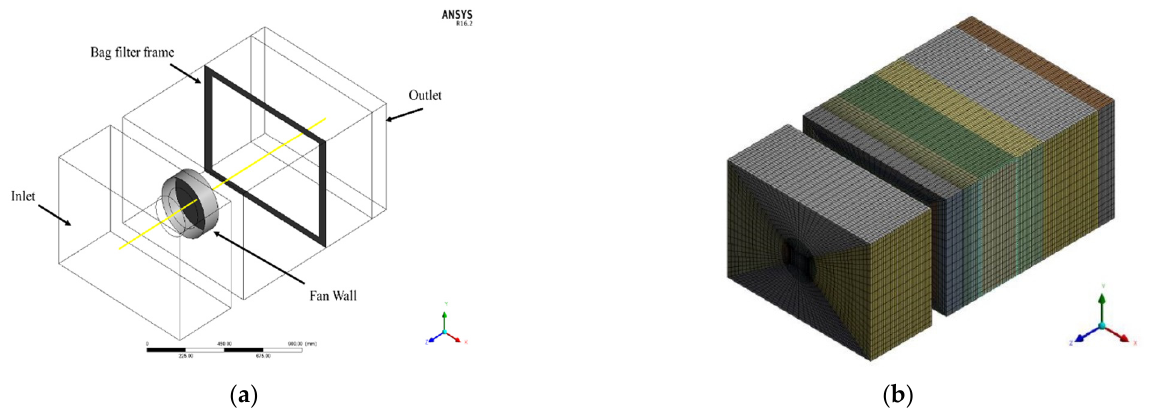
Figure 3. Representation of the: ( a ) AHU geometry and ( b ) mesh used in the simulation.